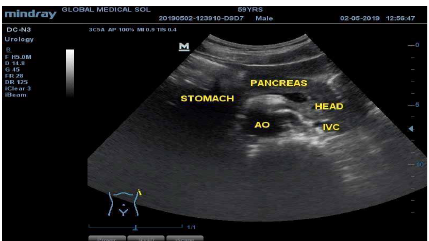
Figure 2: Sonogram of the right hypochondrium in longitudinal plane. The spleen is in the right upper quadrant under the right hemidiaphragm adjacent to the right kidney.